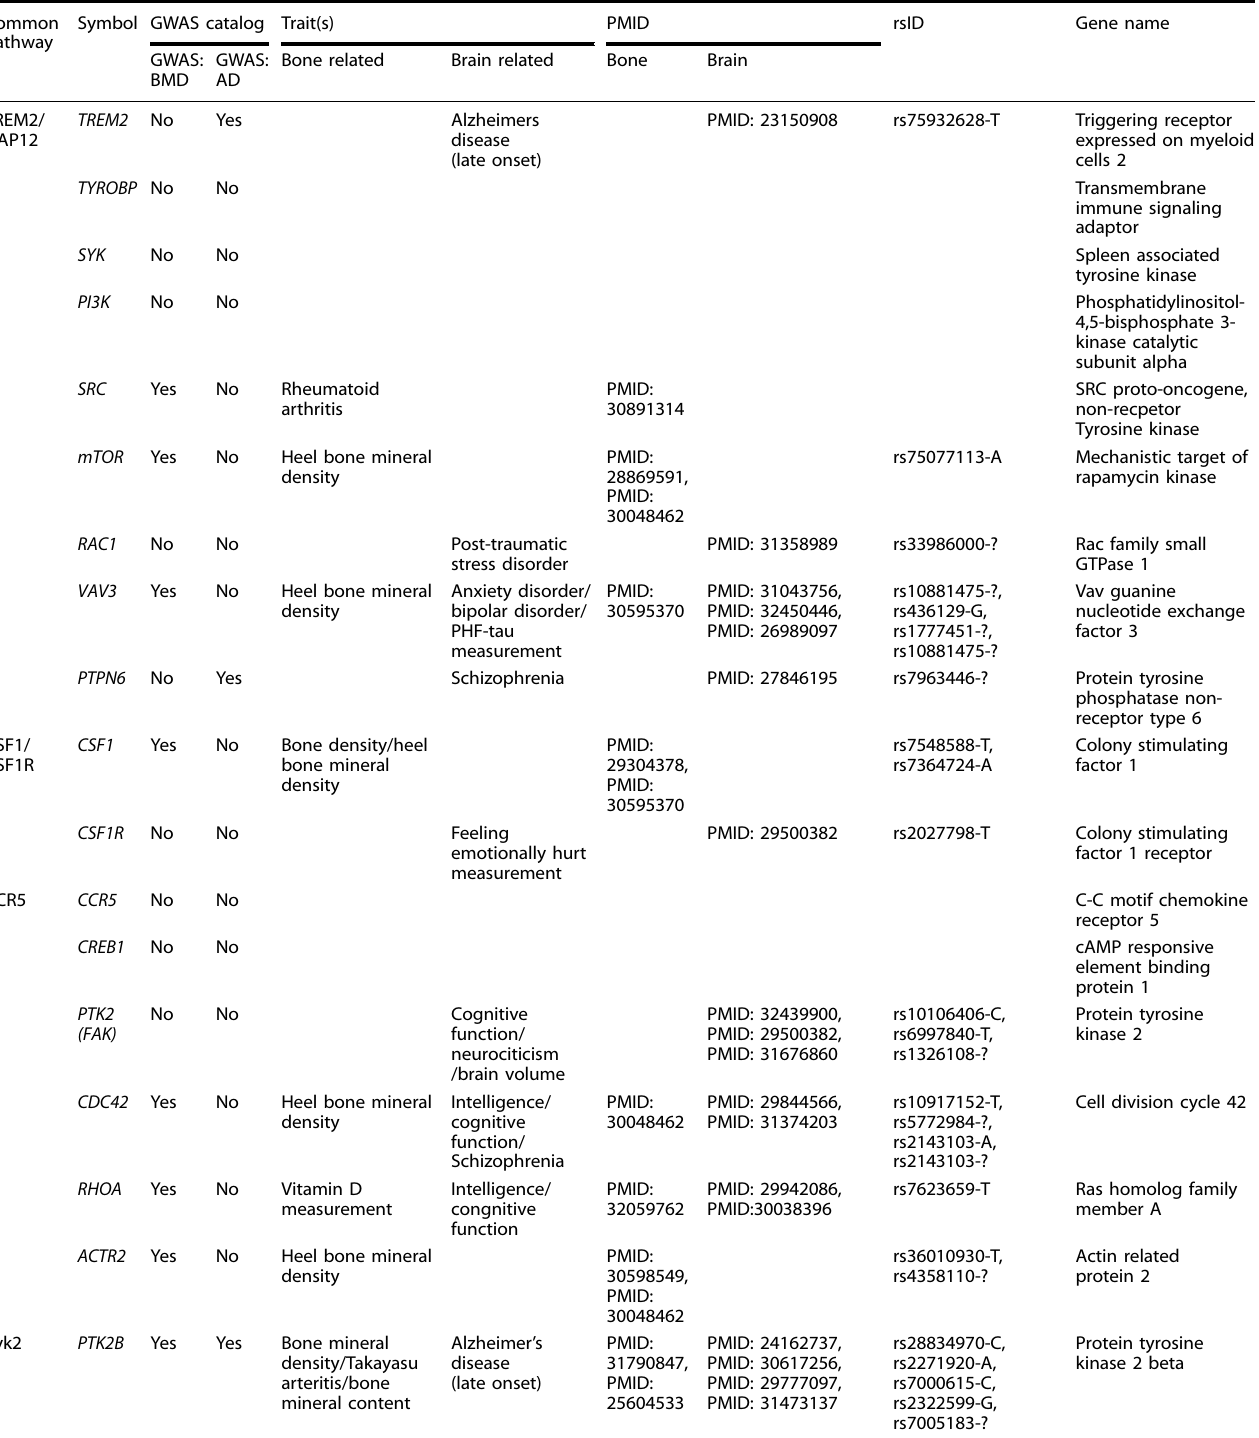
Table 1. Risk alleles in three signaling pathways and PTK2B associated with bone and brain phenotypes from GWAS catalog Common Symbol GWAS catalog Trait(s) pathway